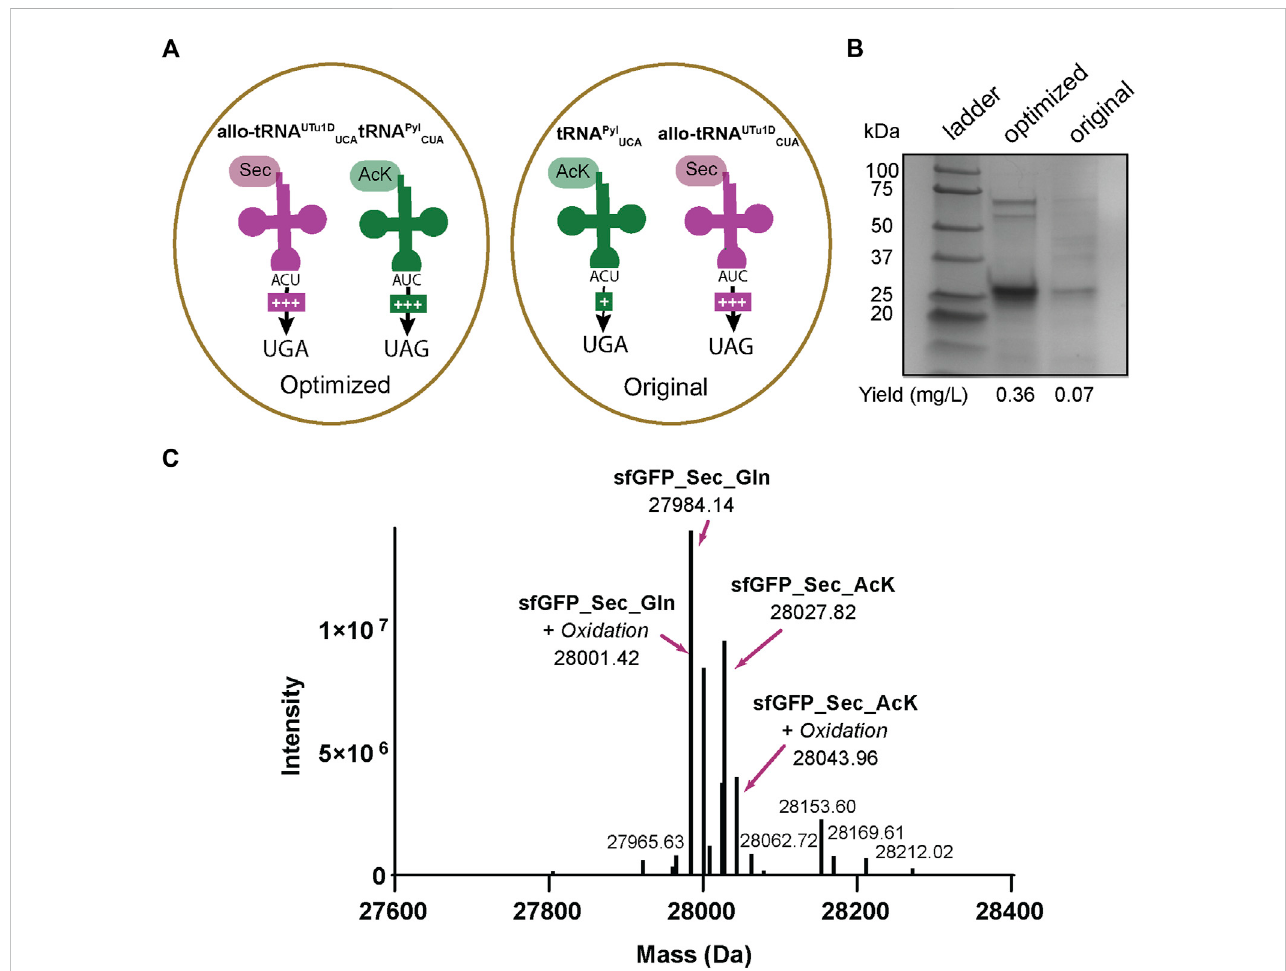
FIGURE 6 Production of AcK-seleno-sfGFP. (A) Schematic of tRNAs used and the respective codons they are expected to recode. Optimized conditions involved Sec insertion at position 2UGA with allo-tRNA UTu1D UCA and N ε -acetyl- L -lysine (AcK) at 151UAG with tRNA Pyl CUA . Original conditions involved AcK insertion at position 2UGA with tRNA Pyl UCA and Sec insertion at 151UAG with allo-tRNA UTu1D CUA . An increase in the amount of + signs correspond to the increased suppression observed. (B) SDS-PAGE shows a strong band around the 25 kDa marker, corresponding to the AcK-seleno-sfGFP size of 28 kDa. An increase in protein yield was found for the anticodon-optimized conditions compared to the original. (C) Intact MS data has multiple peaks which can be assigned to AcK-seleno-sfGFP (37%) and Gln-seleno-sfGFP (63%) with or without an oxidation